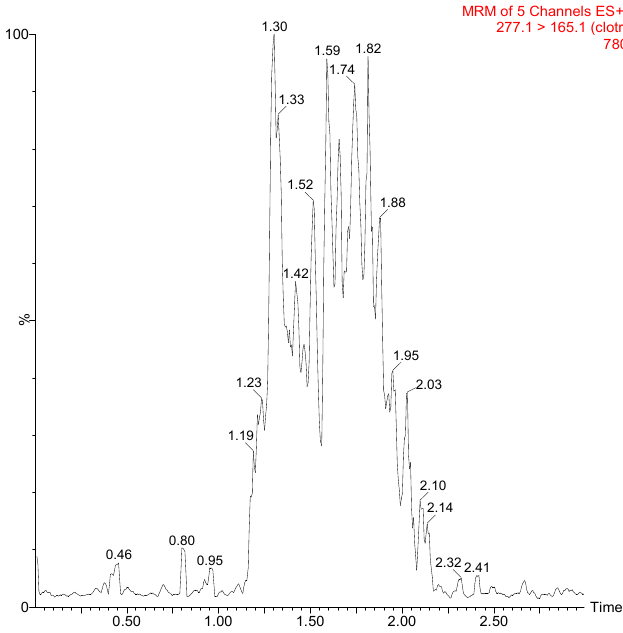
Figure 2. Chromatogram obtained from a blank plasma sample.